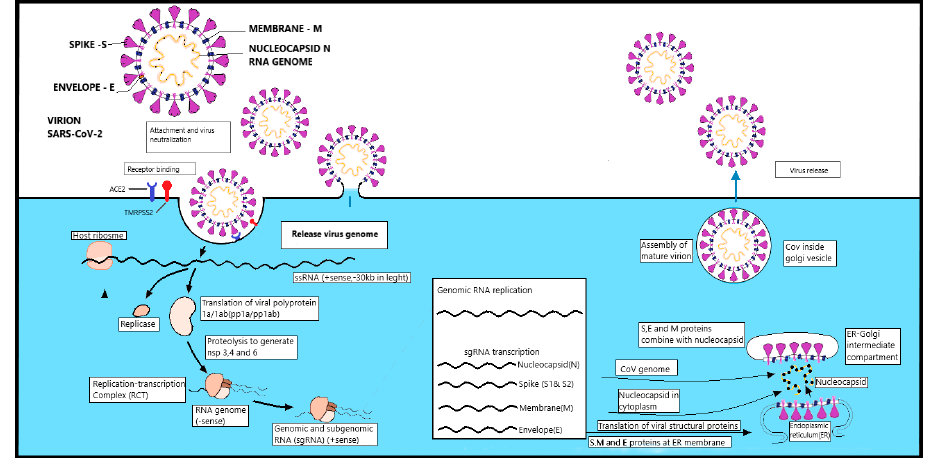
Figure 3. The coronavirus virion and life cycle. The SARS-CoV-2 virion consists of structural proteins, spike—S, envelope—E, membrane—M, nucleocapsid—N, and specific binding of the S protein to ACE2 receptor and the cofactor cell surface serine protease TMPRSS2. Following entry, the release genomic RNA subject it to the immediate translation of two large open reading frames, ORF1a and ORF1b. The resulting polyproteins pp1a and pp1ab are co-translationally and post-translationally processed into the individual non-structural proteins (nsps) that form the viral replication and transcription complex. For viral genomic RNA replication and transcription of subgenomic mRNAs (sg mRNAs) comprise the characteristic set of coronavirus mRNAs. Translated structural proteins translocate into endoplasmic reticulum (ER) membranes and transit through the ER-to-Golgi intermediate compartment, where interaction with N-encapsidated, newly produced genomic RNA results in budding into the lumen of secretory vesicular compartments. Virions are secreted from the infected cell by